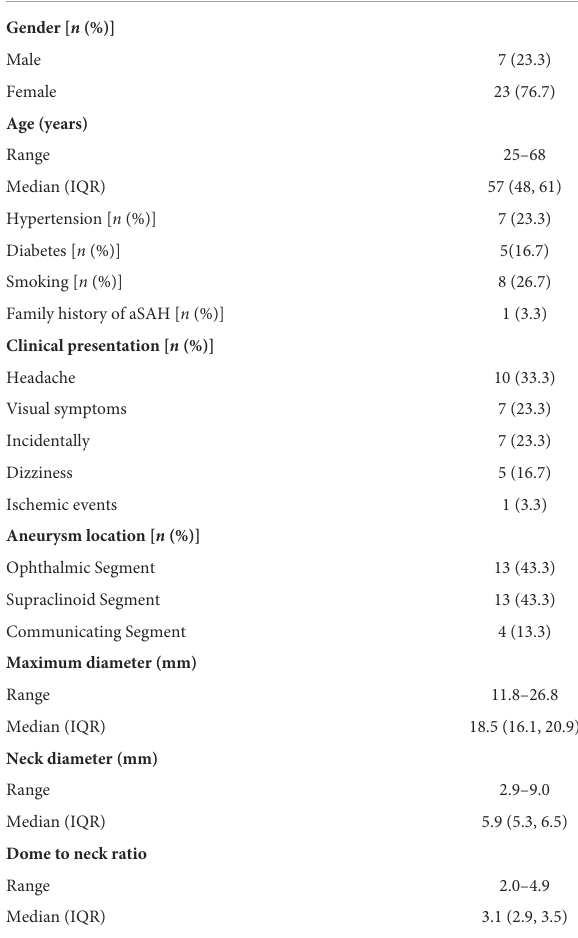
TABLE 1 Characteristics of patients and